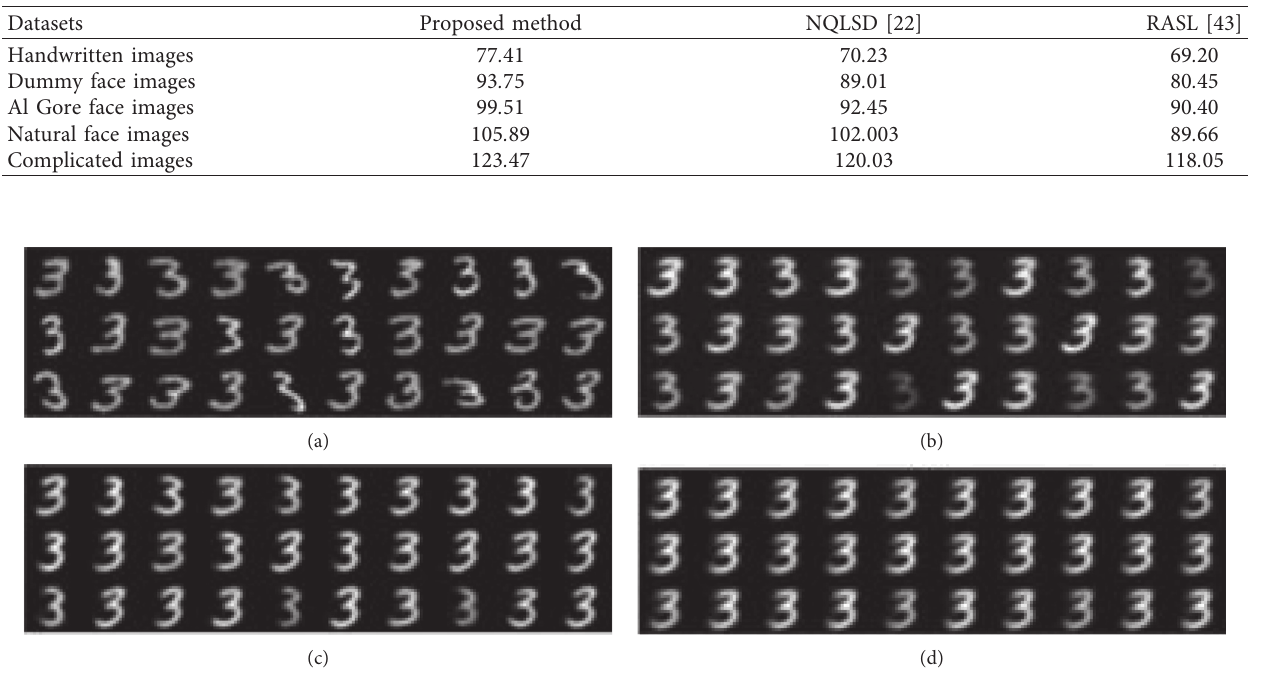
Figure 1: Some recovered handwritten digits. (a) Original, (b) NQLSD, (c) RASL, and (d) proposed method.